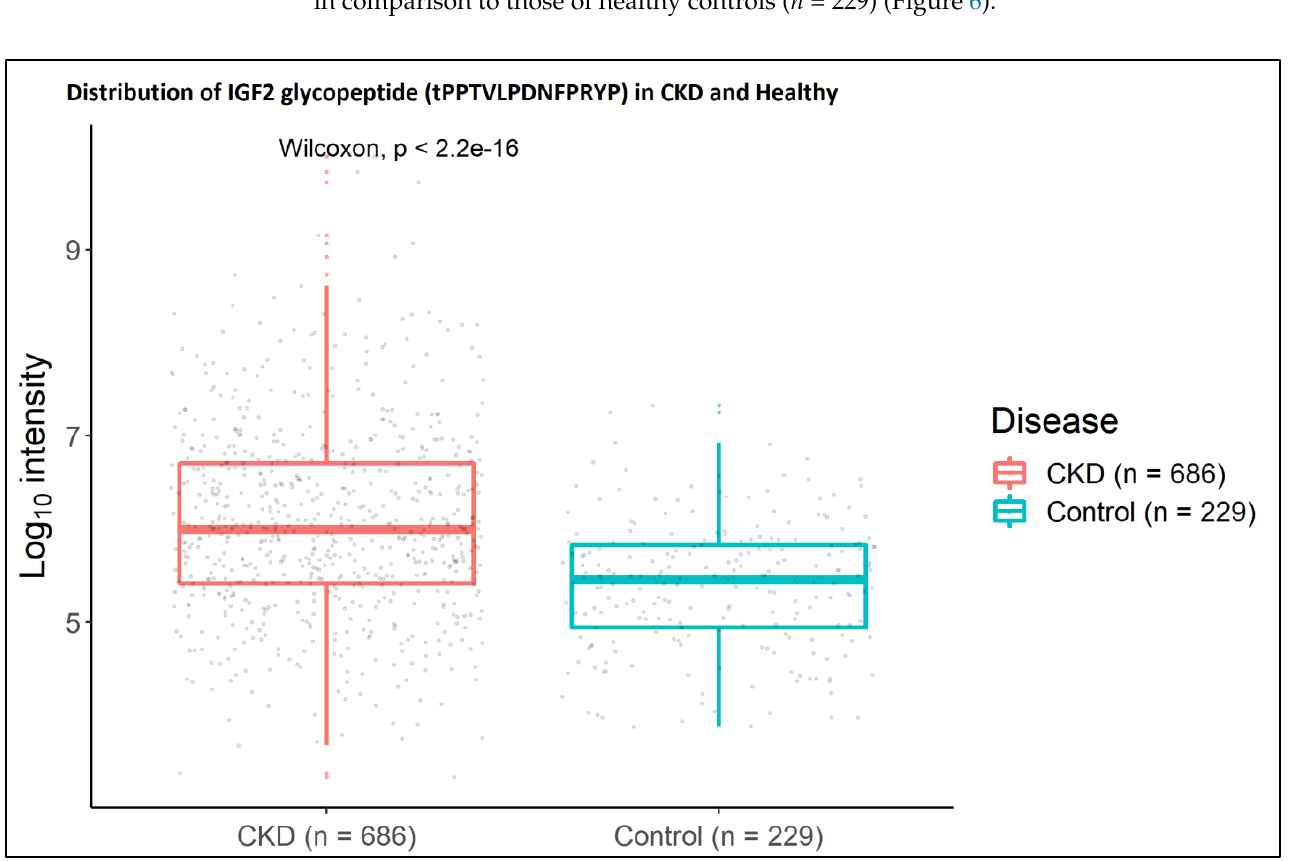
Along the same lines, the urinary IGF2 glycopeptide tPPTVLPDNFPRYP was found at a statistically significant increased abundance in CKD ( n = 686) urinary peptide profiles in comparison to those of healthy controls ( n = 229) (Figure 6).